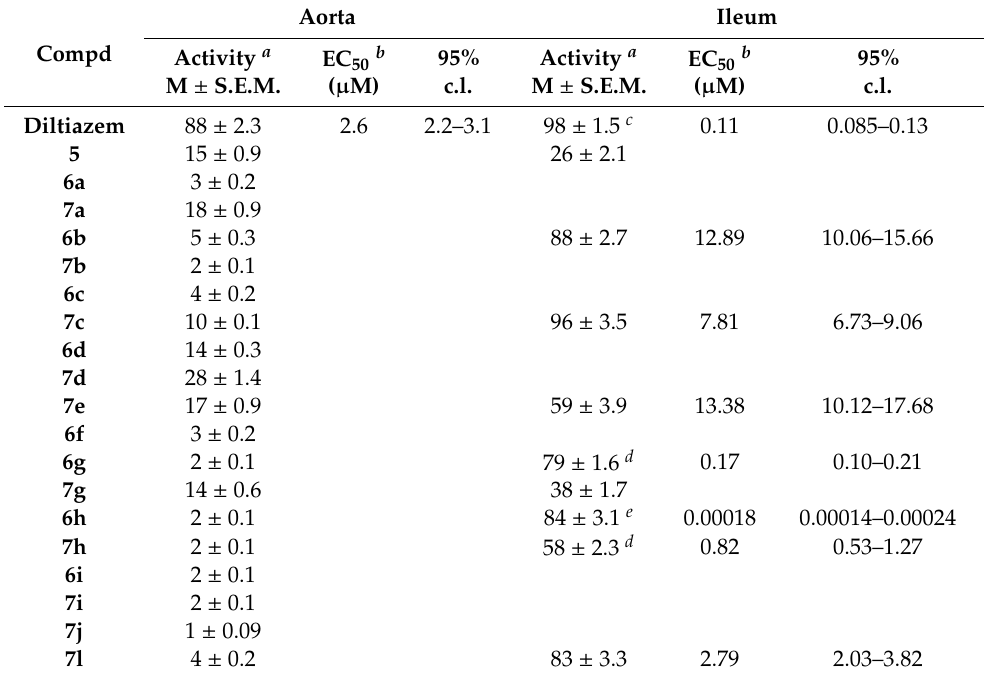
Table 2. Relaxant activity of tested compounds on K + -depolarized guinea pig aortic strips and ileum longitudinal smooth muscle.